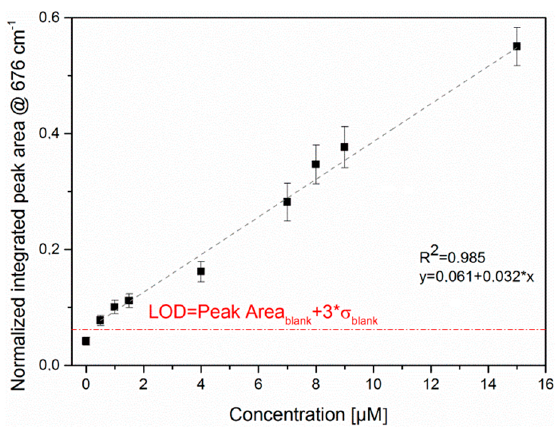
Figure 4. The peak area ratio of the 676 cm − 1 and 240 cm − 1 Raman modes as a function of PYO concentration in aqueous solution in the range between 0.5 and 15 μ M with linear fitting. The red line indicates the calculated LOD.